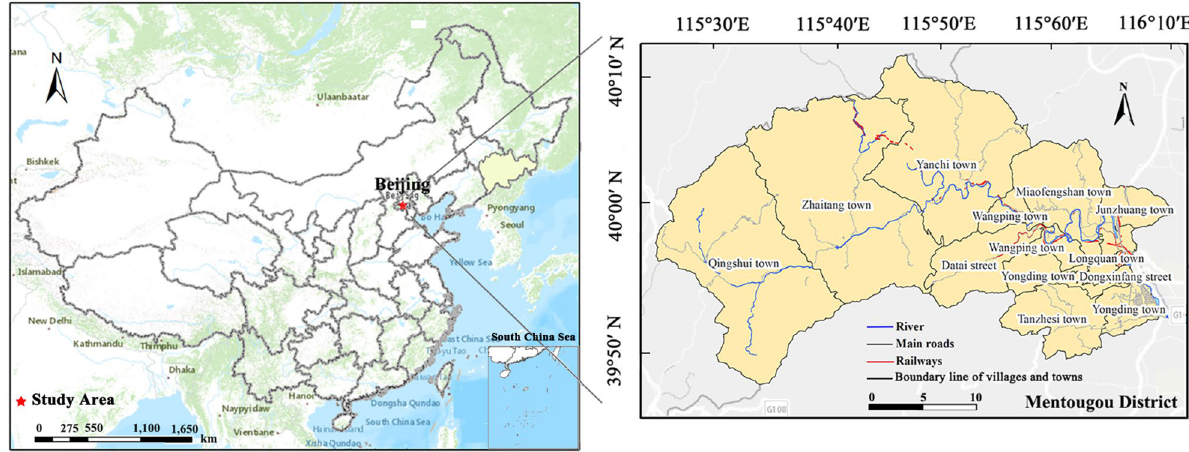
Figure 1. Location of the study area (the map was created by the author using the software ArcGIS 10.5, www. esri.